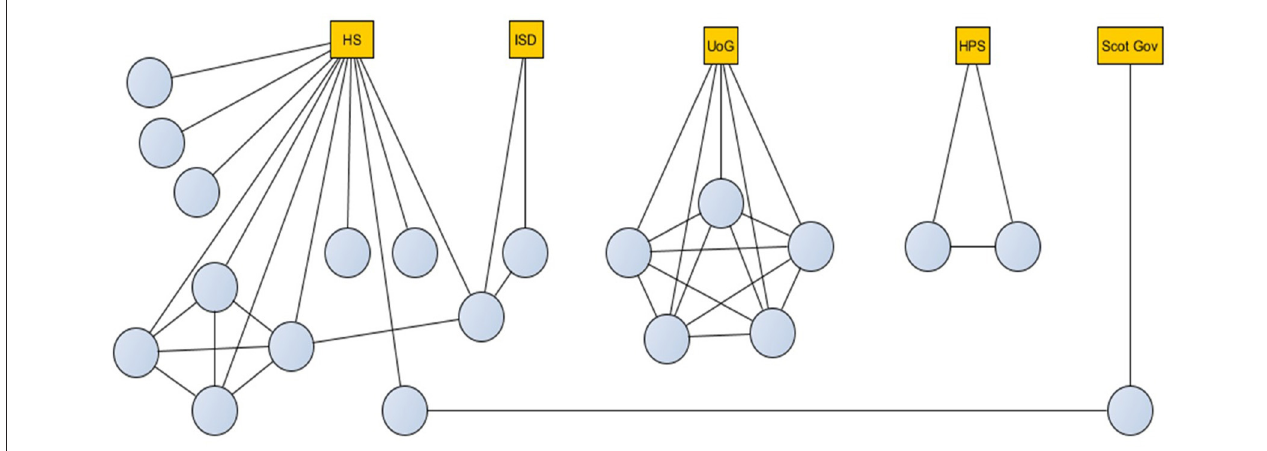
FIGURE 1 | Collaboration and organizational affiliation network for 20 interview and workshop participants. HS, Health Scotland; ISD, Information Service Division; UoG, University of Glasgow; HPS, Health Protection Scotland; Scot Gov, Scottish